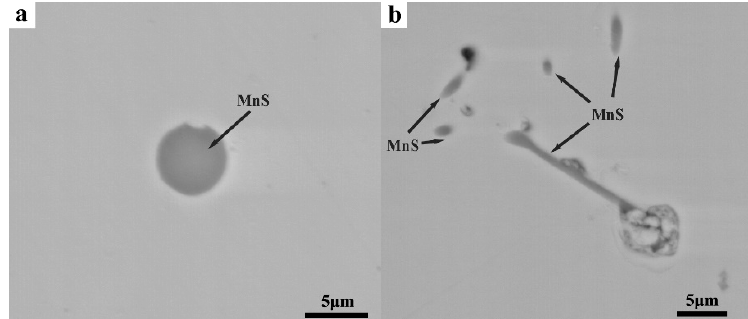
Figure 11. Manganese sulfide (MnS) inclusions in solidified manganese ( a ) spherical MnS inclusion, and ( b ) strip MnS inclusion.